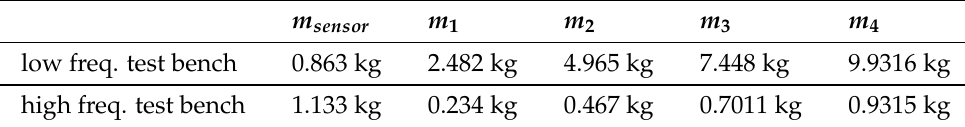
Table 1. Added masses m i at low and high frequency test bench.